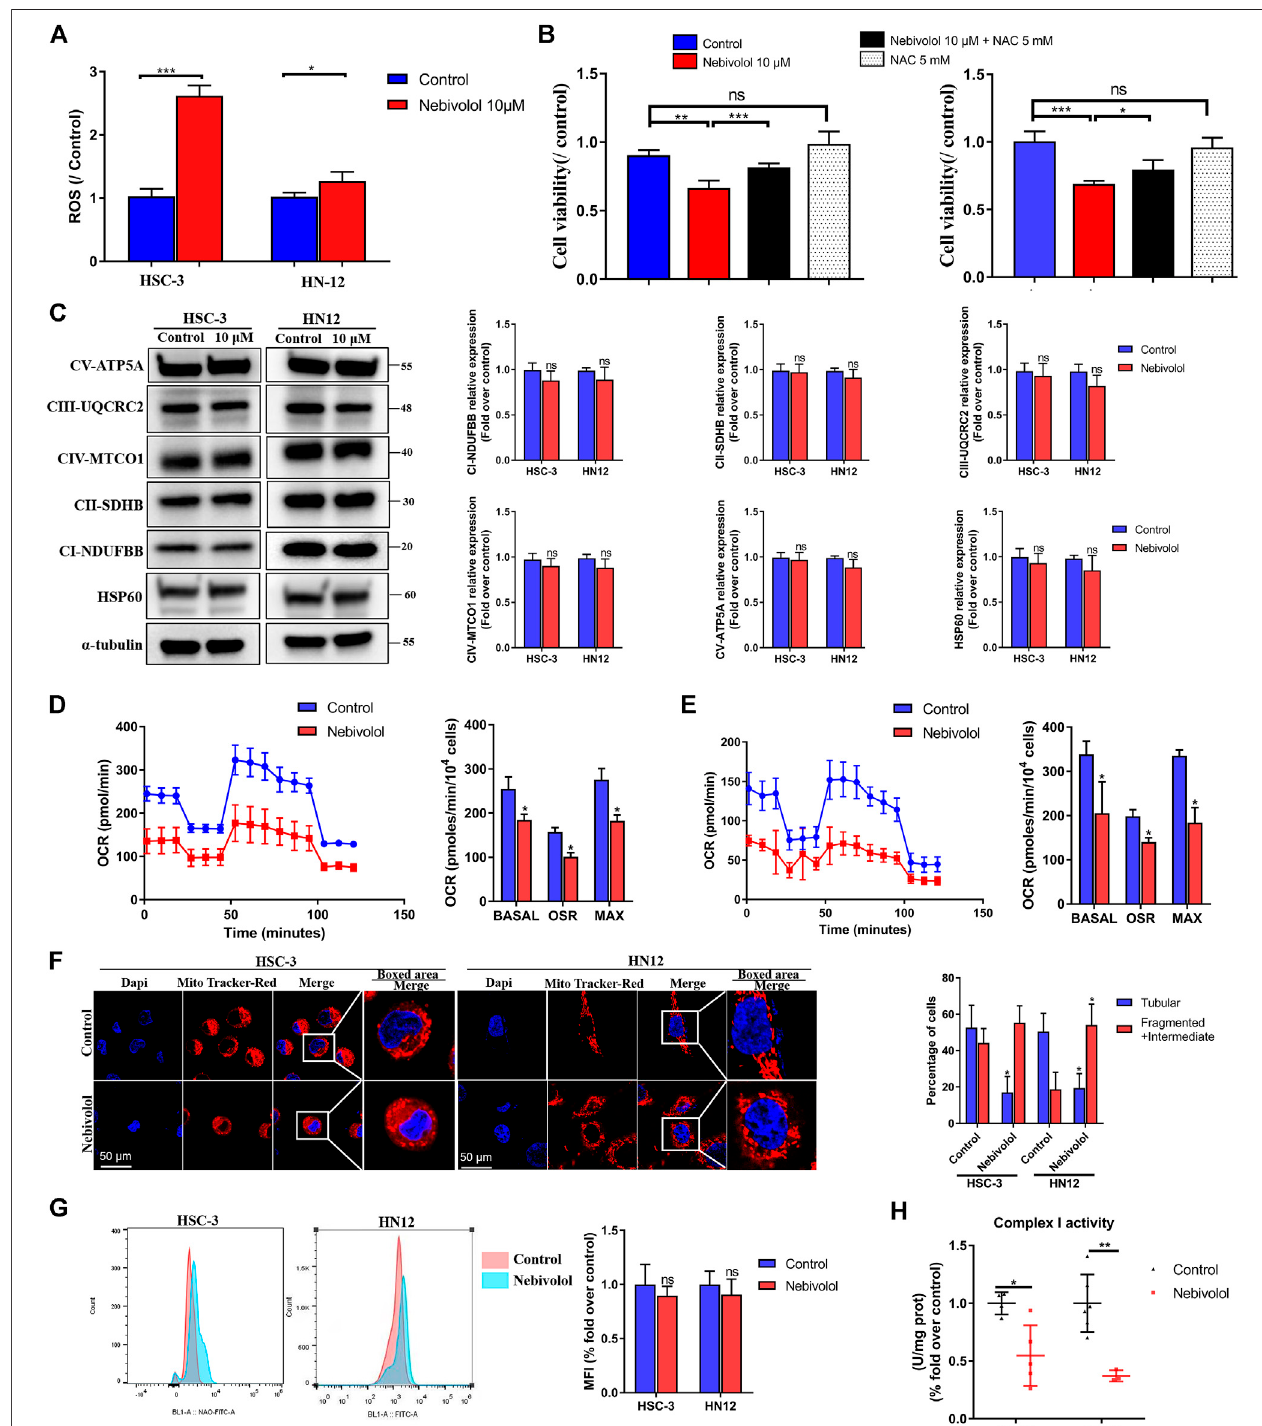
FIGURE 6 | Nebivolol increased ROS level to induce apoptosis via a disturbing mitochondrial function in OSCC cells. (A) The ROS level was enhanced after nebivololinductionfor24 hinOSCCcells. (B) TheCCK-8assaywasusedtodeterminethecellviabilityofnebivololinthepresenceorabsenceofpretreatmentofNACon OSCC cells for 24 h. (C) Effects of OXPHOS proteins expression in OSCC cells after being treated with 10 μ M nebivolol for 12 h. The data are representative of fi ve independent experiments. The CI-NDUFBB, CII-SDHB, CIII-UQCRC2, CIV-MTCO1, CV-ATP5A, and HSP60 from the blots were quanti fi ed. (D) Oxygen consumption rate (OCR) was detected when treated with or without 10 μ M nebivolol in the HSC-3 cells. The basal respiration, ATP production, and maximal respiratory capacity were quanti fi ed. (E) OCR was detected when treated with or without 10 μ M nebivolol in the HN12 cells. The basal respiration, ATP production, and